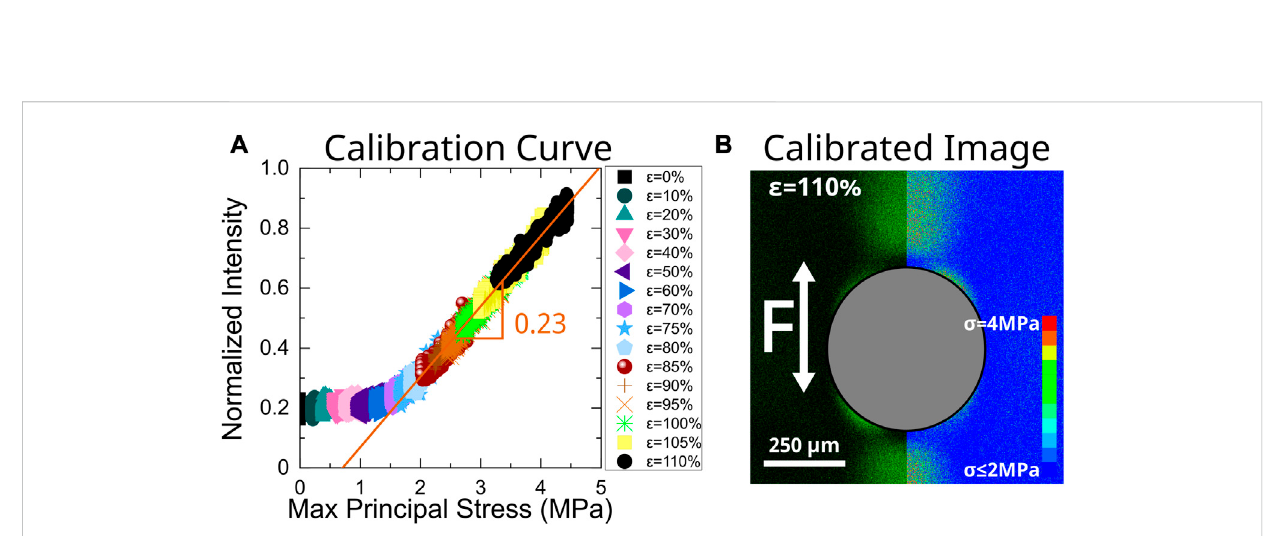
FIGURE 4 Calibration of mechanophore intensity to max principal stress. (A) Line scans at 0 ° relative to the loading direction were taken from the edge of the particle into the matrix. Due to disagreement between the model and experiment near the particle interface, the fi rst 100 μ m of this scan are excluded. IntensitylinescansfromexperimentswereplottedagainststresslinescansobtainedfromFEAatvarious strainstepsasshowninFigure3.Intensityvalues obtained at high strains have been systematically shifted upwards to account for photoreversion of the SPN resulting from repeated imaging. The rawcurveandshiftfactorsareshowninSupplementaryFigureS4.Alinear fi twasappliedtothedataabovethemechanophorethresholdactivation stress (approximately 2 MPa for the sensitivity of the detector and SPN concentration used in this study). Applying this linear fi t to our experimental images allows us to create calibrated images (B) of max principal stress in our composite materials. The calibrated image was obtained at an applied engineering strain of